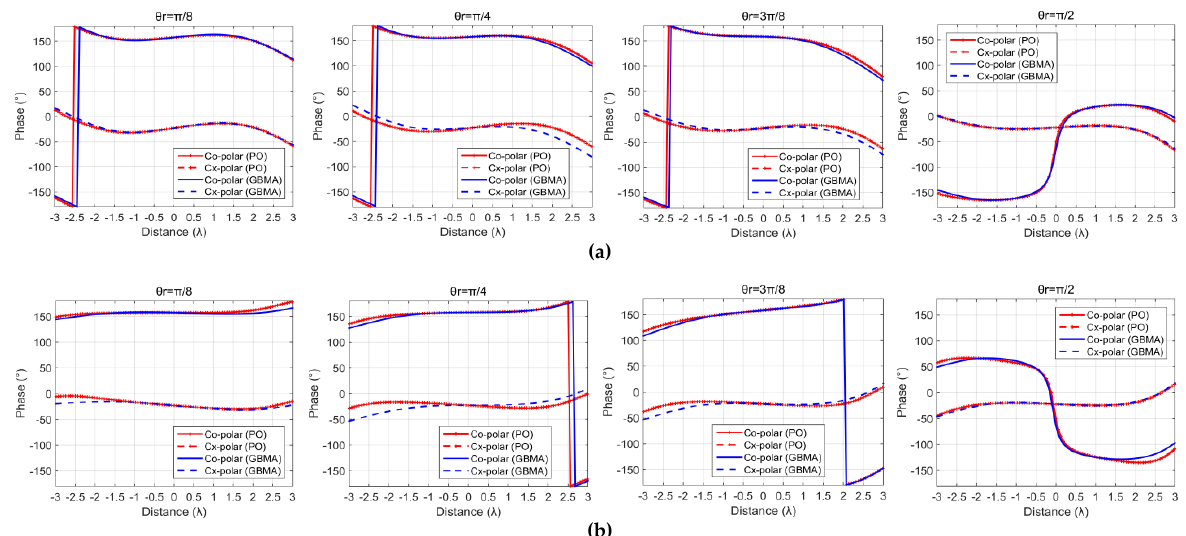
Electronics 2021 , 10 , x FOR PEER REVIEW Figure 6. Phase distributions of 3-D systems with different 𝜃 r : (a) E-plane; (b) H-plane. Figure 6. Phase distributions of 3-D systems with different θ